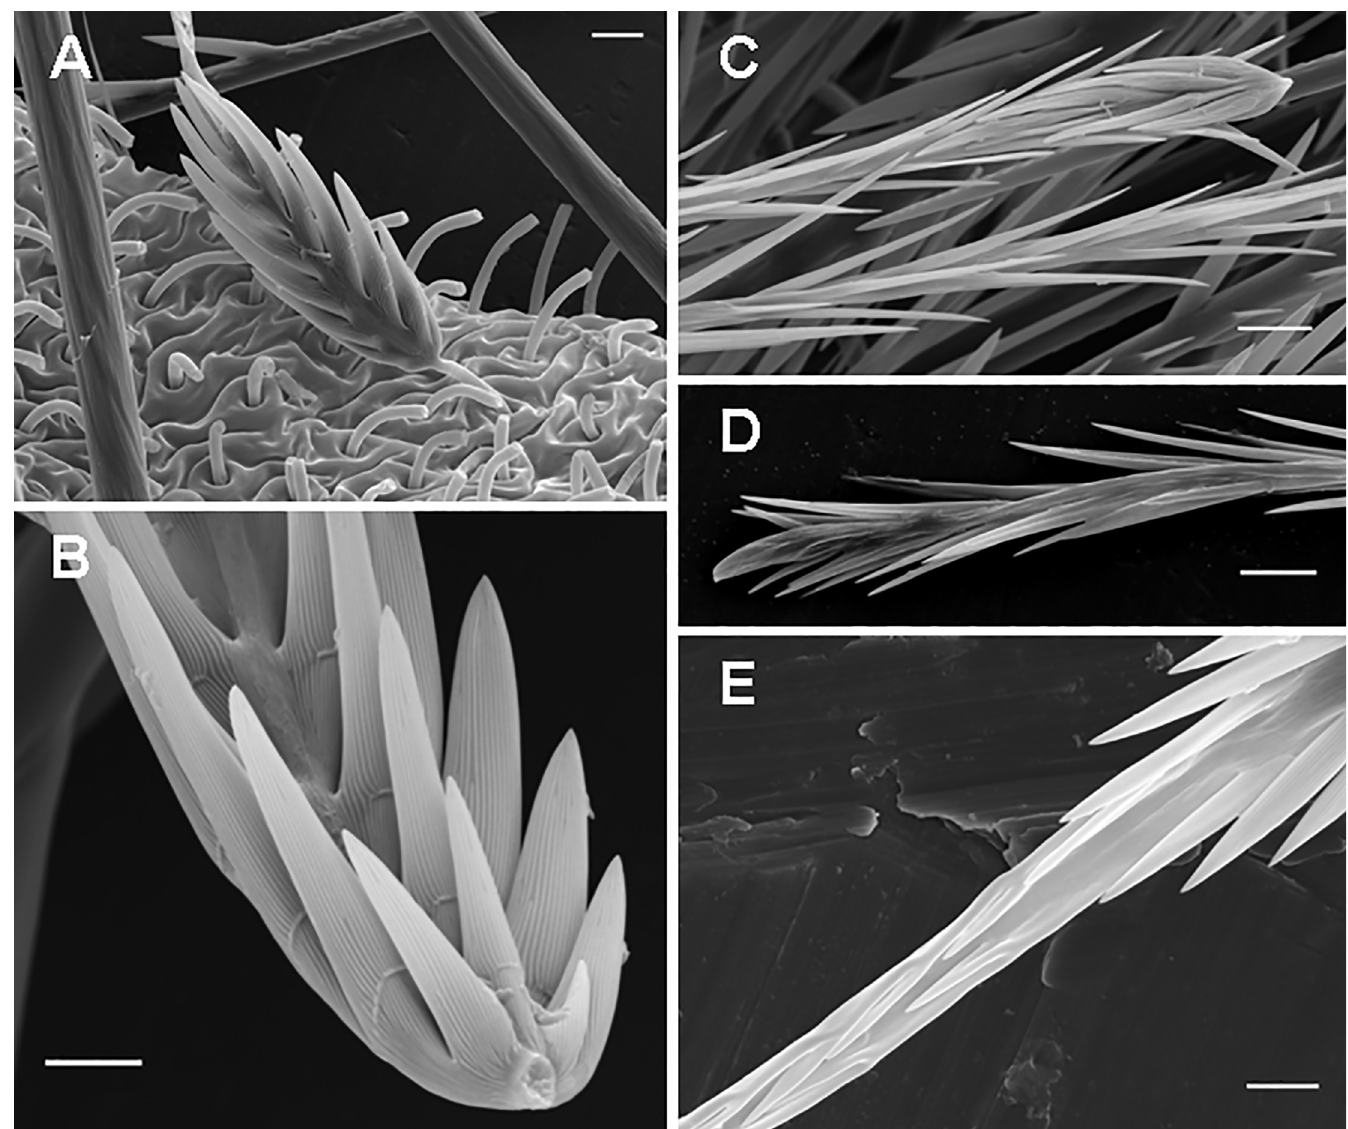
Fig 4. Urticating setae of Brachypelma smithi , immature male. (A) Basic type I, basal section, connected to the dorsal abdominal surface by a supporting stalk and surrounded by other supporting stalks without urticating setae. Scale bar = 10 μ m. (B) Basic type I, basal section with three rows of barbs. Scale bar = 5 μ m. (C) Type I, subtypes I c , midsection (below) and basal section (above) with basal barbs reduced in both number and size. Scale bar = 10 μ m. (D) Type I, subtype I c , basal section with strongly reduced basal barbs. Scale bar = 10 μ m. (E) Basic type I, detail of the midsection with two parallel longitudinal rows of short, confluent reversed barbs in the left lower part of the figure. Scale bar = 5 μ